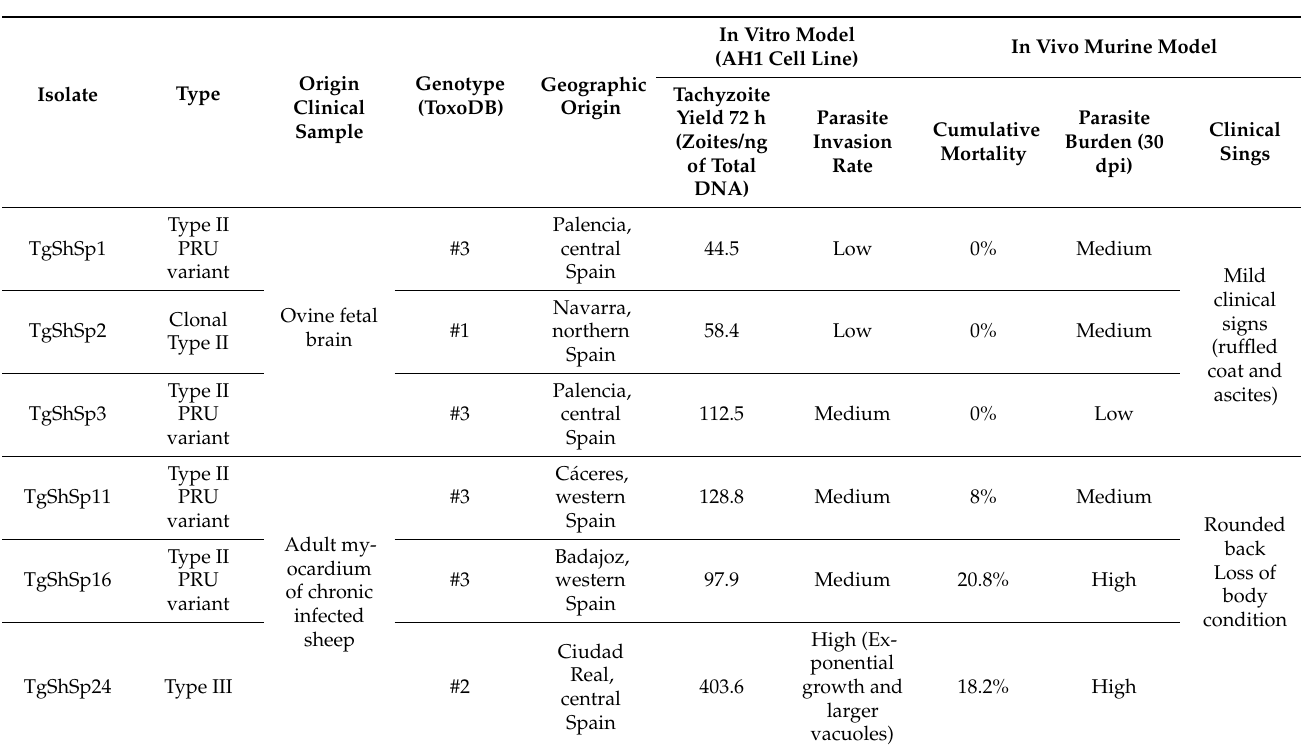
Table 1. Toxoplasma gondii Spanish isolates selected for in vitro OvMØs characterization. All data were reported in previous studies